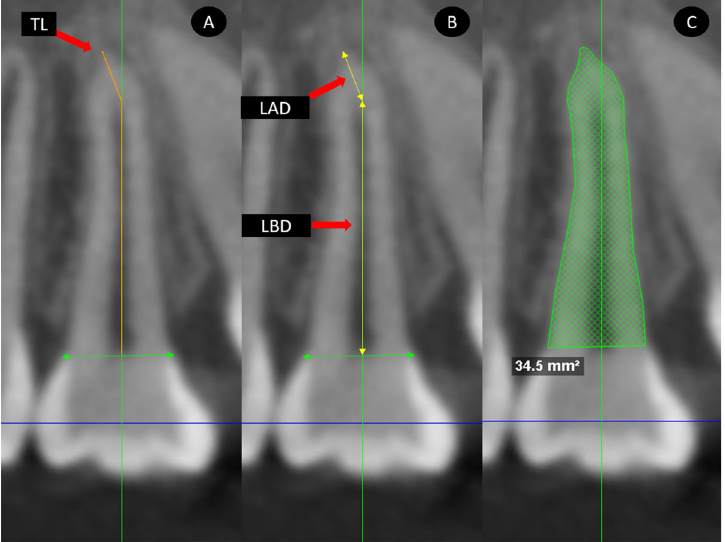
Fig 4. Sagittal section measurements. A, total length (TL). B, length before dilaceration (LBD), length after dilaceration (LAD). C, evaluation of root